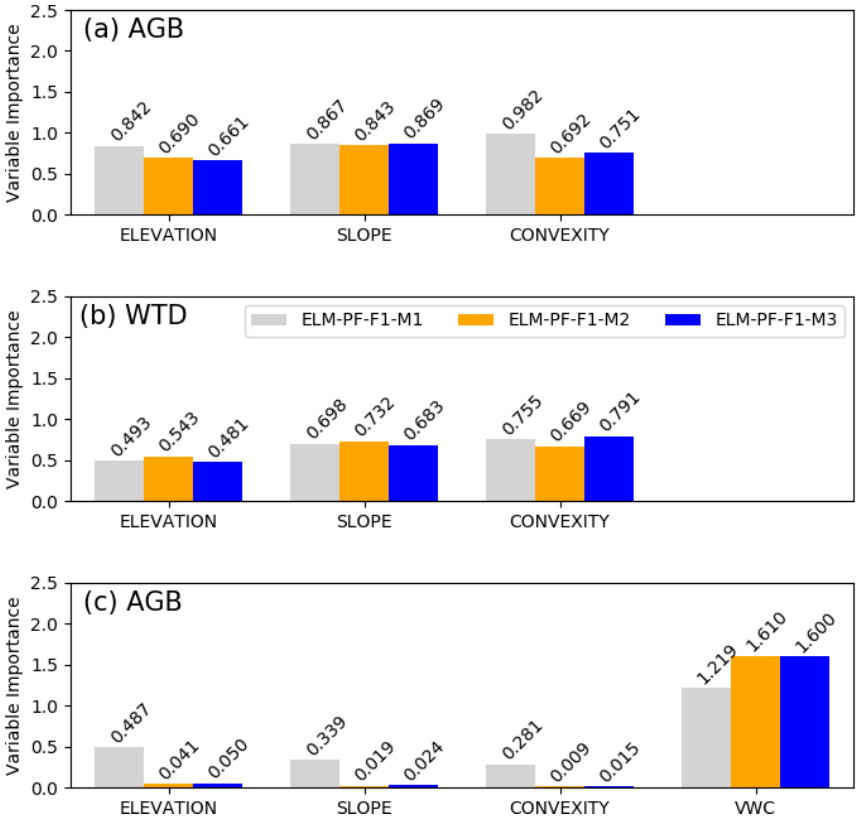
Figure 7. Variable importance for the explanatory variables ( x axis) included in the random forest model for the site-wide simulated AGB (a) and WTD (b) as response variables using elevation, slope, and convexity as explanatory variables and for the simulated AGB (c) using VWC as an additional explanatory variable. The number on top of each bar is the importance